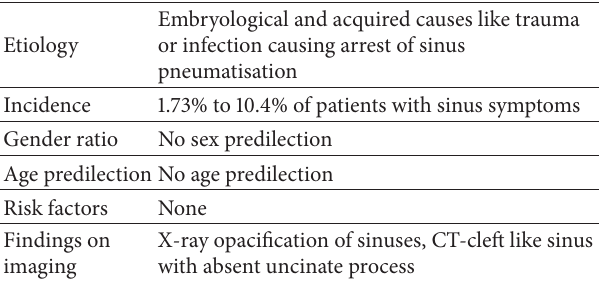
Table 1: Summary